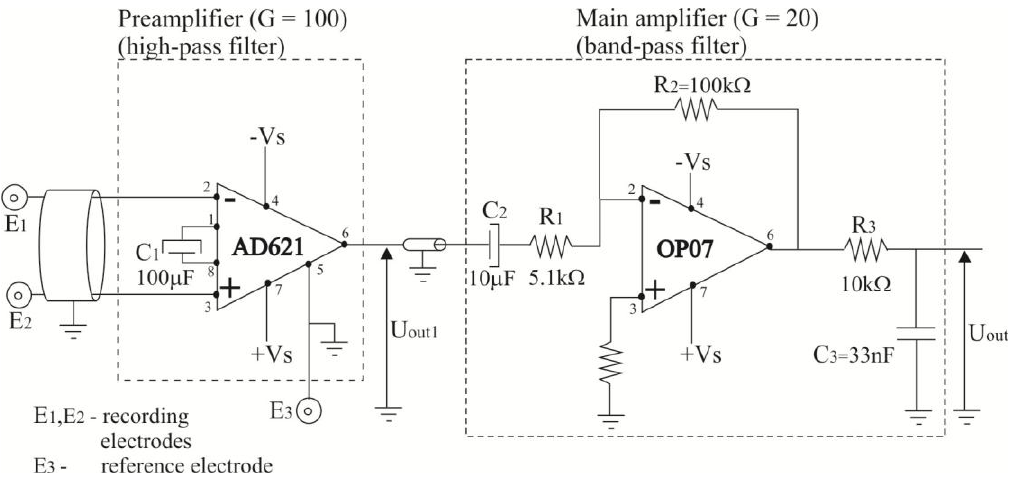
Figure 2. The electric scheme of the bioamplifier consisted of two stages: the preamplifier and the main